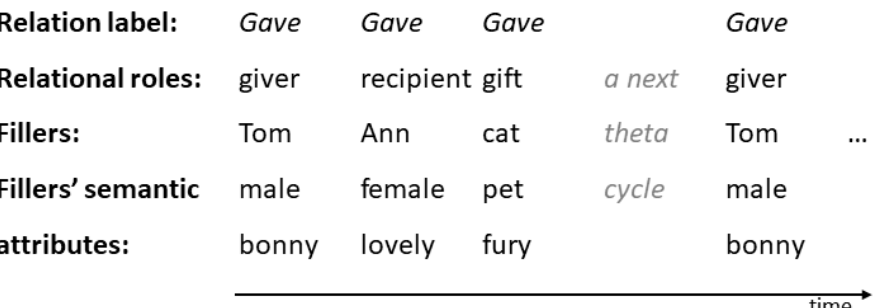
Figure 1. An example of temporal pattern of bindings in LISA’s representation of the relation instance Gave (Tom, Ann, cat).